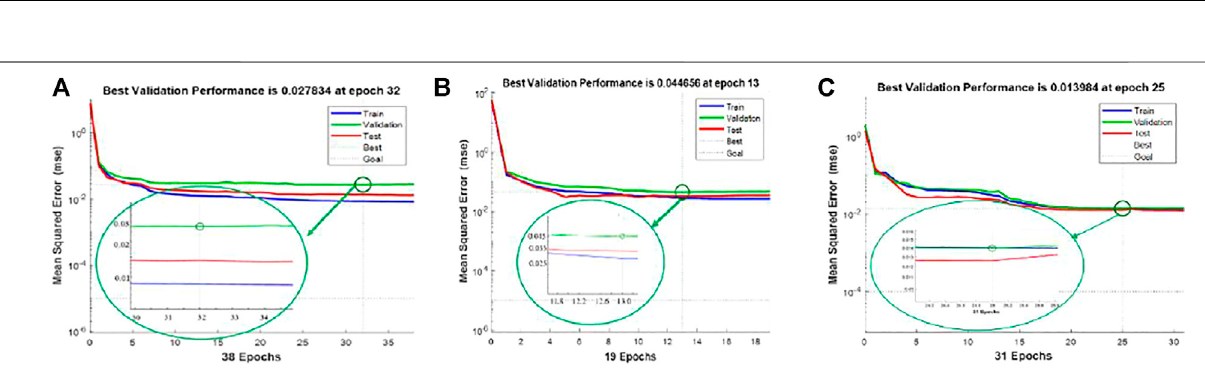
Frontiers in Materials |